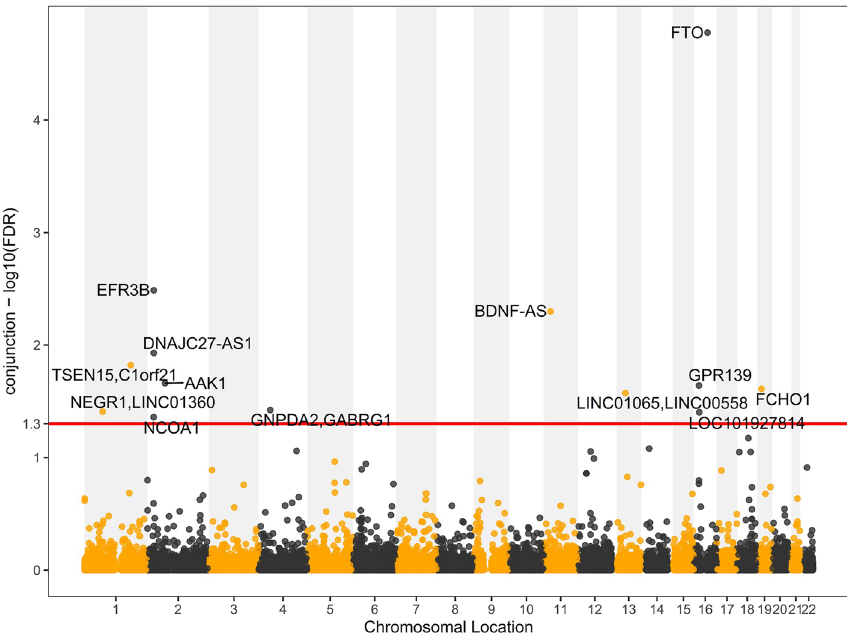
Figure 2. Conjunction Manhattan plot of − log 10 ( ccFDR ) values for CBMI and CAD. The red line marks the − log ( ccFDR ) value of 1.3 corresponds to ccFDR of 0.05. The figure shows the genomic locations of shared 10 variants and the overlapped genes between CBMI and CAD identified by cFDR and GPA method.